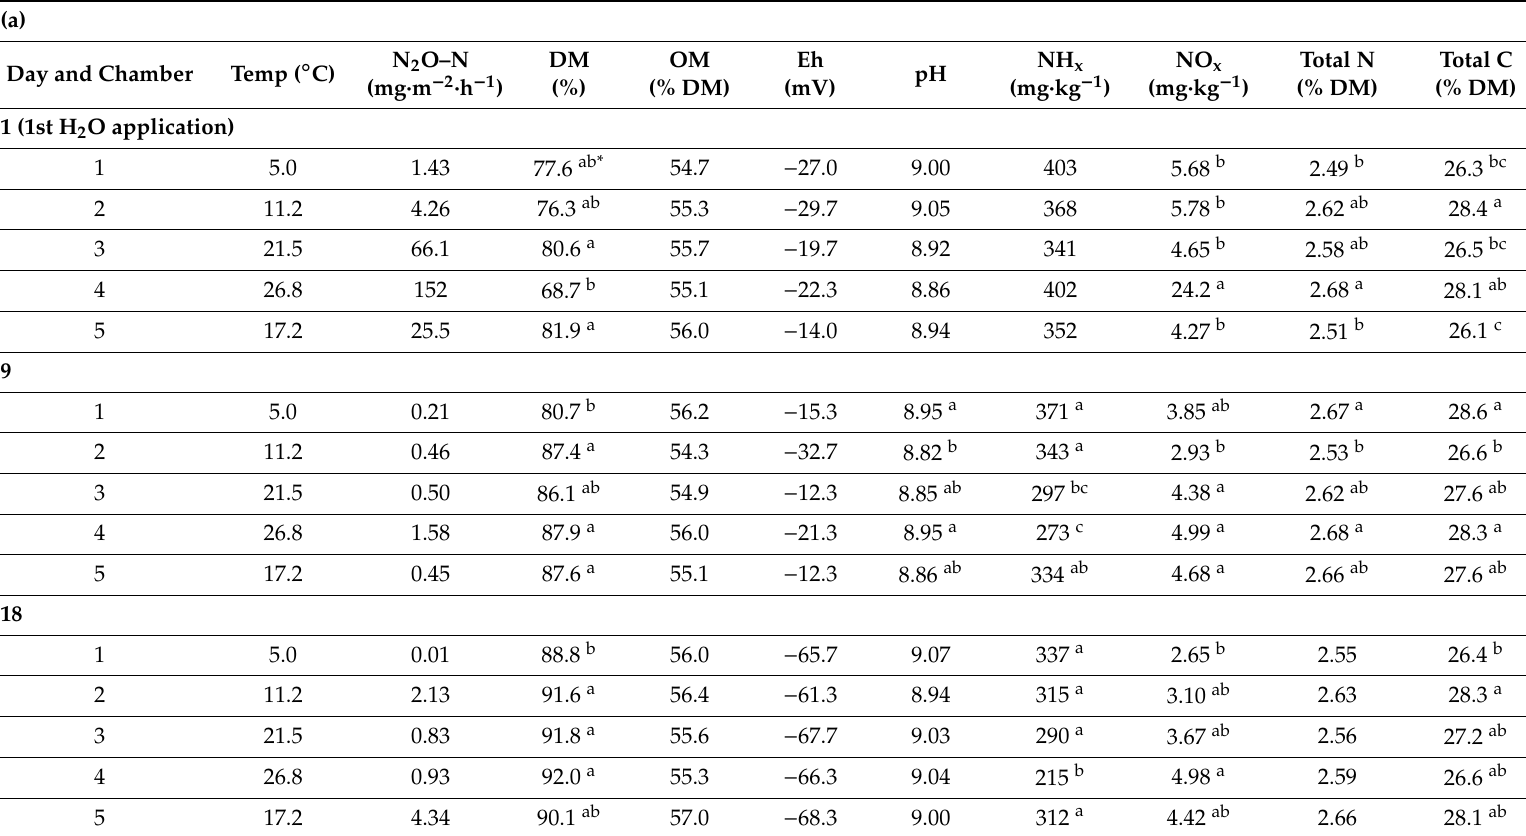
Table 1. Nitrous oxide (N 2 O) emissions, temperature and manure characteristics in five chambers (1, 2, 3, 4, and 5) that received two simulated rainfall episodes. Chambers were held at temperatures ranging from 5.0 to 46.2 ◦ C, with increases on Day 22 (changes in italics). Samples were taken at ( a ) 0–5 cm and ( b ) 5–10 cm depths.